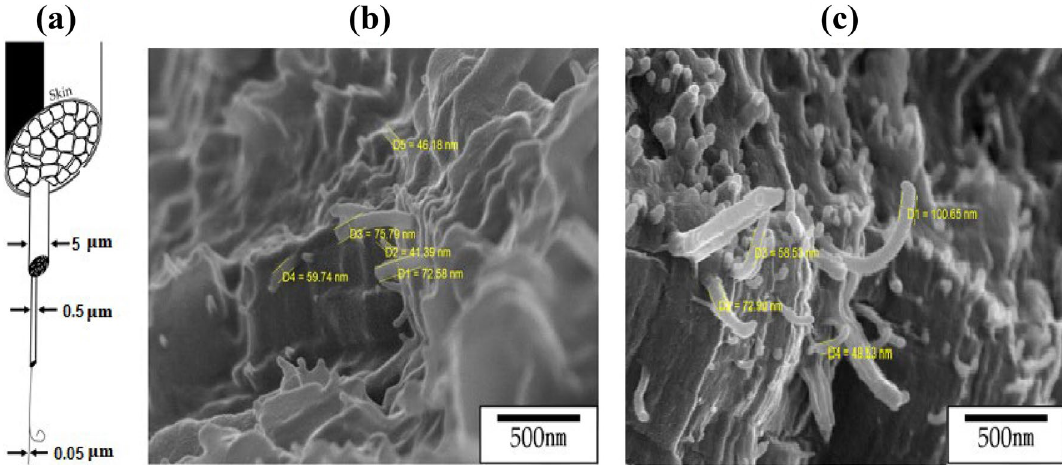
Figure 8. ( a ) Hierarchical structures in the Co-TLCP fibers 43 and SEM images of the ( b ) 240/9 and ( c ) 240/12 annealed